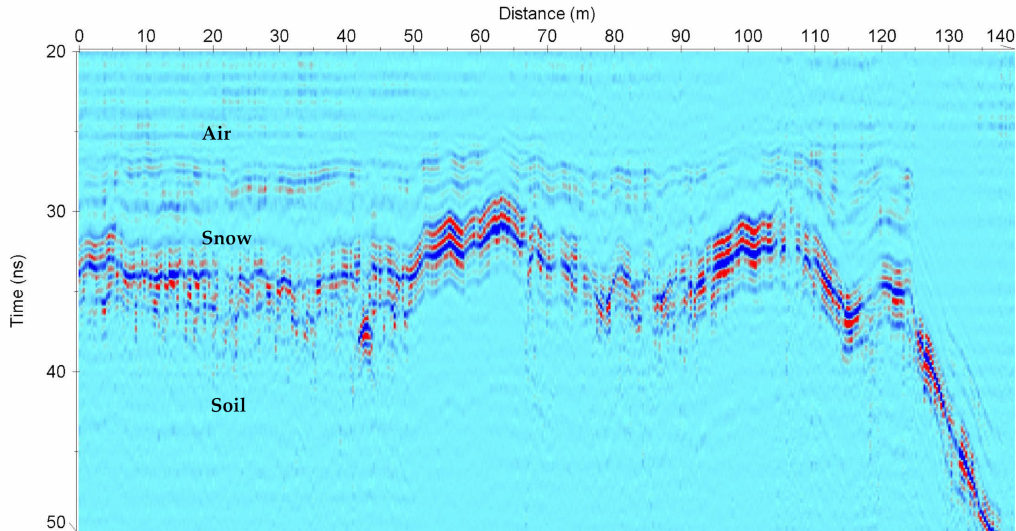
Figure 8. Zoom on the interfaces depicted by a drone GPR section (line #3).